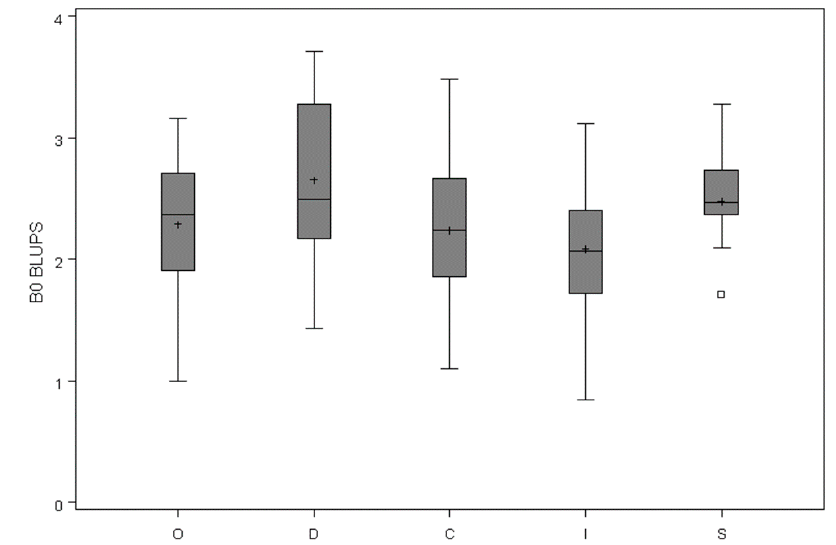
Figure 5. The distribution of means, standard deviation, and range of best linear unbiased predictions (BLUPs) from the MB0 model by crown class. O = open-grown, D = dominant, C = co-dominant, I = intermediate, S = suppressed.